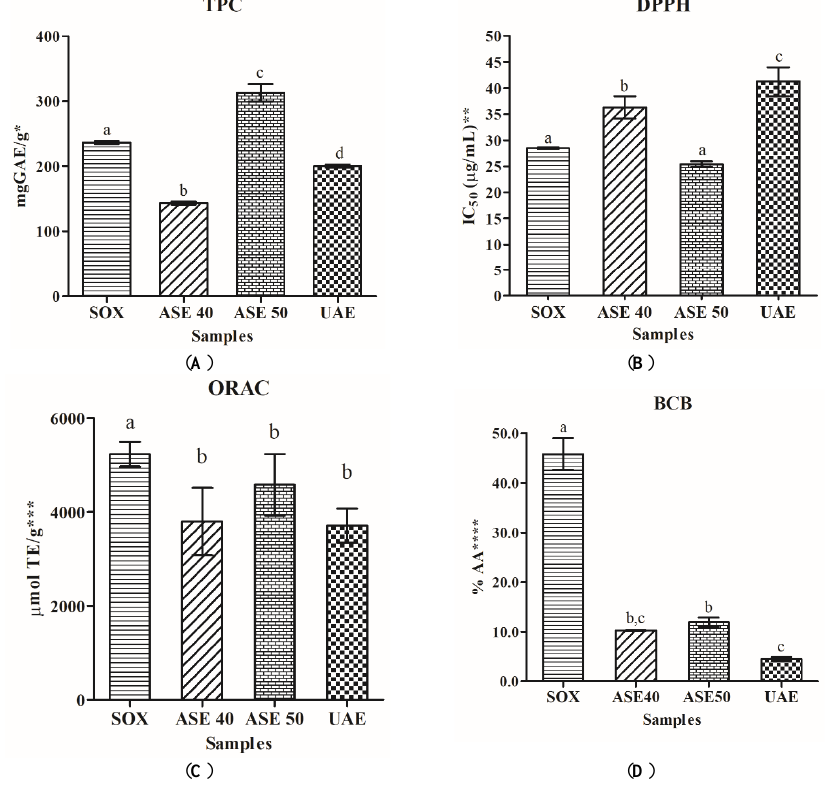
Figure 2. Samples are extracts obtained by Soxhlet extractive technique (SOX), Accelerated Solvent Extraction at 40 ◦ C (ASE 40), Accelerated Solvent Extraction at 50 ◦ C (ASE 50) and Ultrasound-assisted extraction (UAE). Histograms of ( A ) Total Phenolic Content (TPC); ( B ) DPPH method; ( C ) Oxygen Radical Antioxidant Capacity (ORAC) assay; ( D ) β -Carotene Bleaching assay (BCB); data are expressed as means ± standard deviation from three experiments; * mg GAE / g = mg of Gallic Acid Equivalents per gram of dried sample; ** IC 50 ( µ g / mL) = concentration of the sample able to scavenge 50% DPPH radical; *** µ mol TE / g = µ mol of Trolox Equivalents per gram of dried sample; **** % AA = percentage of Antioxidant Activity at final sample concentration of 0.2 mg / mL; di ff erent superscripts in the same row indicate significant di ff erence ( p < 0.05). Antioxidants 2020 , 9 , x